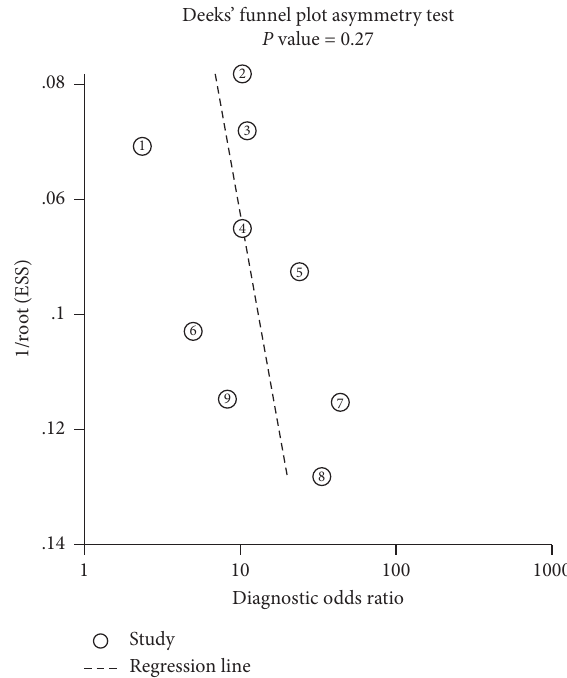
Figure 2: Deek funnel plot asymmetry test for publication bias, with P < 0 . 1 indicating publication bias. There was no significant publication bias ( P � 0 .